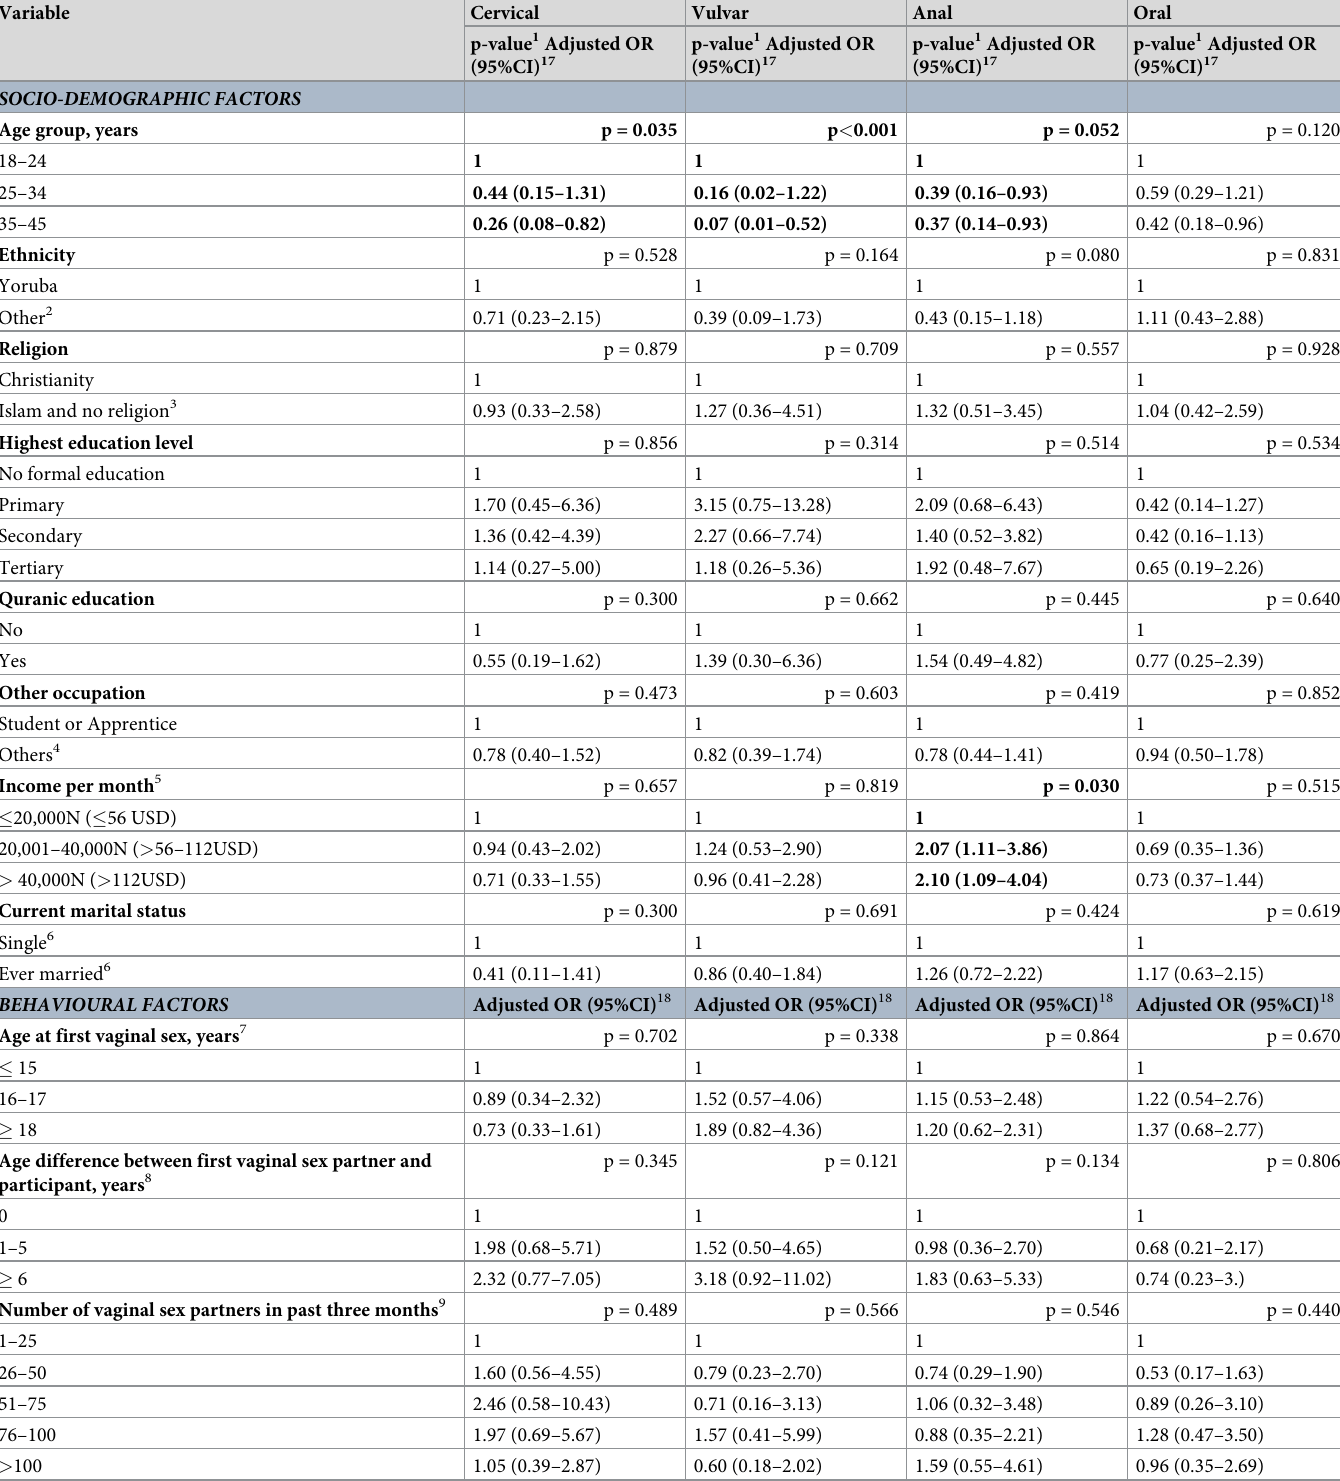
Table 4. The adjusted analysis of factors associated with cervical, vulvar, anal and oral human papillomavirus infection among brothel-based female sex workers in Ibadan,